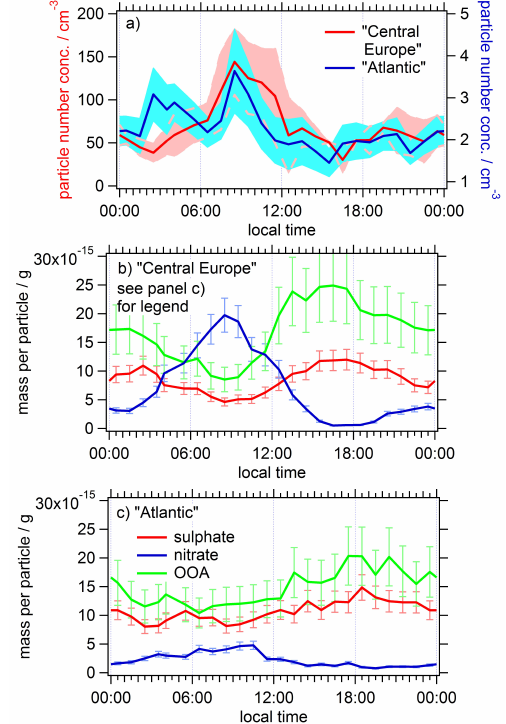
Fig. 6. Average diurnal cycle of the number concentration of parti- cles classified as OOA and inorganics, separated for central Europe and Atlantic air masses (a) . Standard deviations of the average val- ues are shown as light shaded areas. Average diurnal cycles of mass per particle of nitrate, sulphate, and OOA within the particles clas- sified as OOA and inorganics for central Europe (b) and Atlantic air masses (c) . Error bars shown are calculated according to Eq.